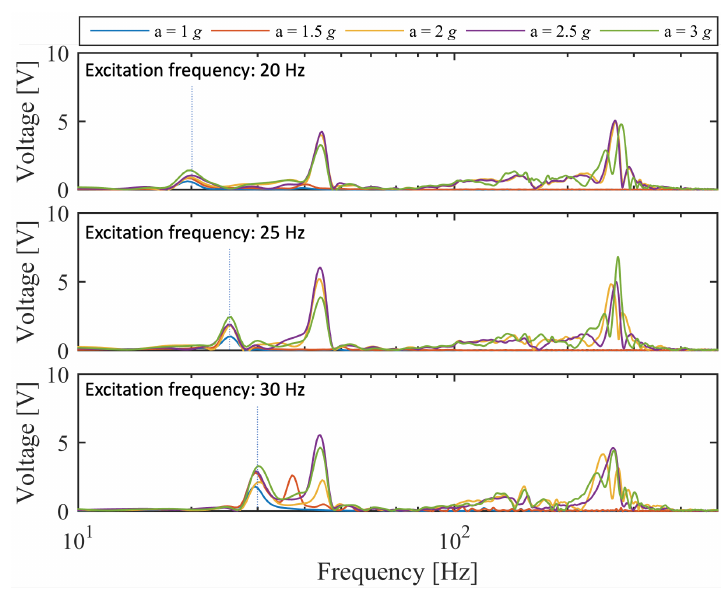
Figure 17. Fourier transform of the open-circuit output voltage obtained during the STB tests with sinusoidal excitation at frequencies of 20, 25 and 30 Hz with peak amplitudes of 1, 1.5, 2, 2.5, and 3 g. The vertical dashed lines denote the excitation frequency.